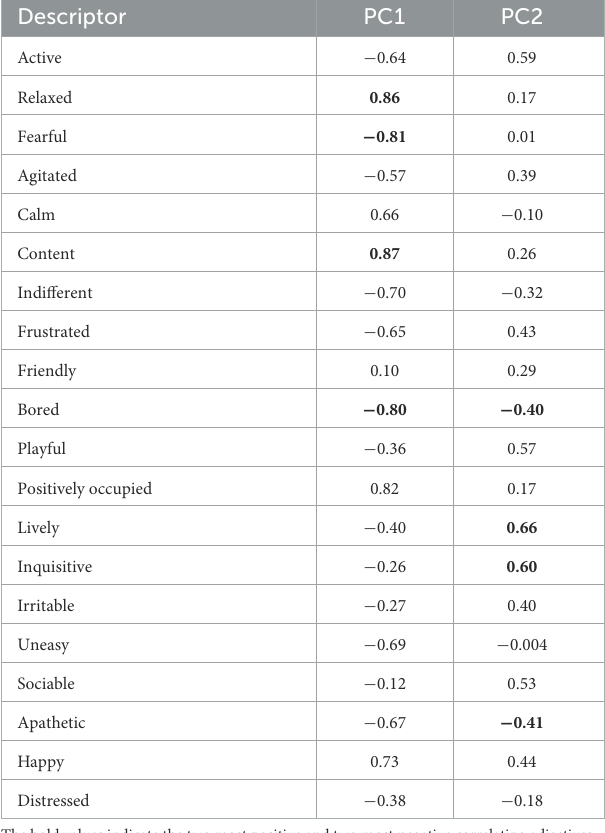
TABLE 5 Group 1 and Group 2: Principal components 1 and 2, displaying associated correlations between variables and principal components for each behavioural